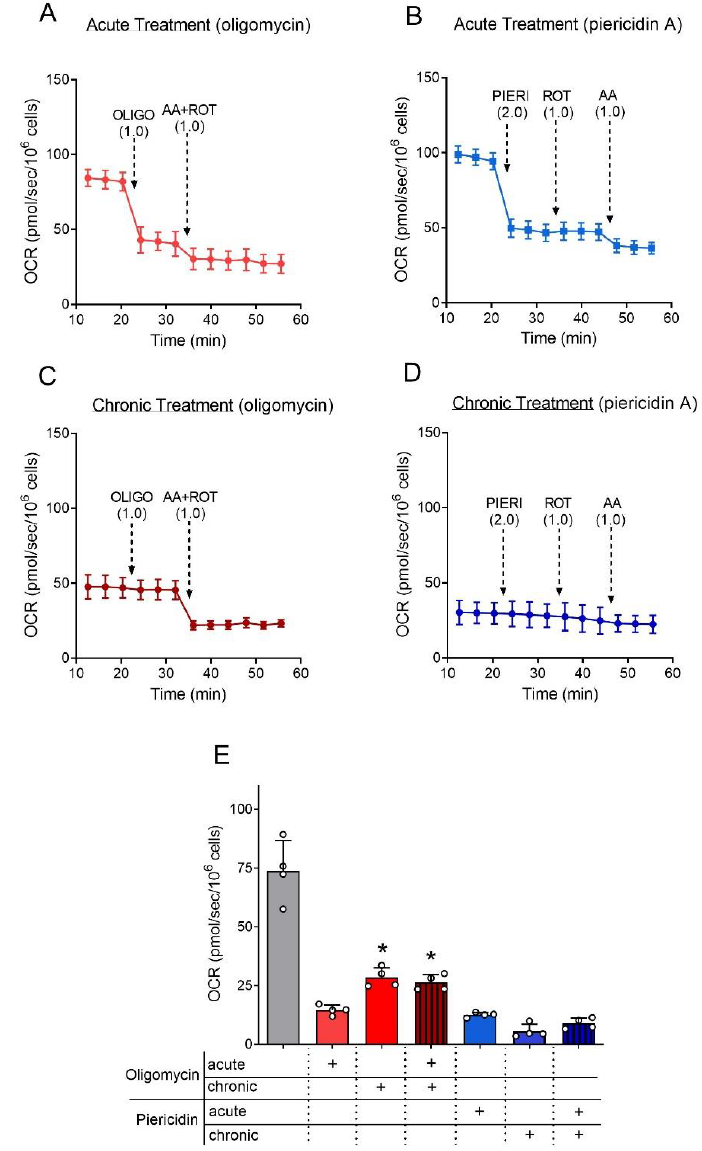
Figure 3. Effect of oligomycin and piericidin A on the oxygen consumption rate (OCR) of adhered astrocytes. Astrocytes (60,000 cells/well) were plated in a 24-well plate specific for use in the Seahorse XFe24 analyzer and cultured in Medium 3 with DMSO (0.025%, v/v ; solvent) or the mitochondrial inhibitors oligomycin (1 µg/mL) and piericidin A (2 µM) present from D1. Cells were evaluated after 48 h (D3) when oligomycin or piericidin A were also added during the runs. ( A ) Representative trace of OCR of adhered astrocytes treated with DMSO and acutely treated with oligomycin. Where indicated, a bolus addition of 1.0 µg/mL oligomycin (OLIGO) was performed, followed by 1 µM antimycin plus 1 µM rotenone (AA + ROT). ( B ) Representative trace of OCR of adhered astrocytes treated with DMSO and acutely treated with piericidin A. Where indicated, a bolus addition of 2.0 µM piericidin A (PIERI) was performed, followed by ROT and AA. ( C ) Representative trace of OCR by adhered astrocytes chronically treated with oligomycin. Where indicated, additions of OLIGO, ROT, and AA were made. ( D ) Representative trace of OCR by adhered astrocytes chronically treated with piericidin A. Where indicated, additions of PIERI, ROT and AA were made. ( E ) Antimycin-sensitive OCR values from adhered astrocytes in basal condition, chronically and/or acutely treated with piericidin A and oligomycin. * Statistically significant by two-way ANOVA, post-hoc Bonferroni, compared to Oligomycin (acute). p < 0.05. N =